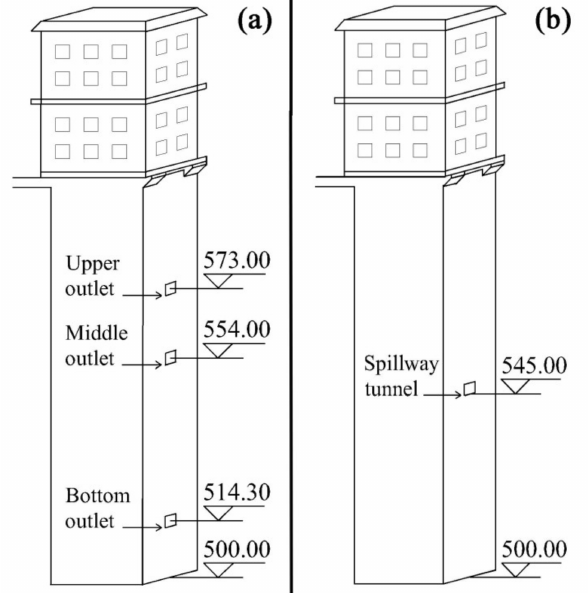
Figure 5. Sketches of the ( a ) intake tower and ( b ) spillway